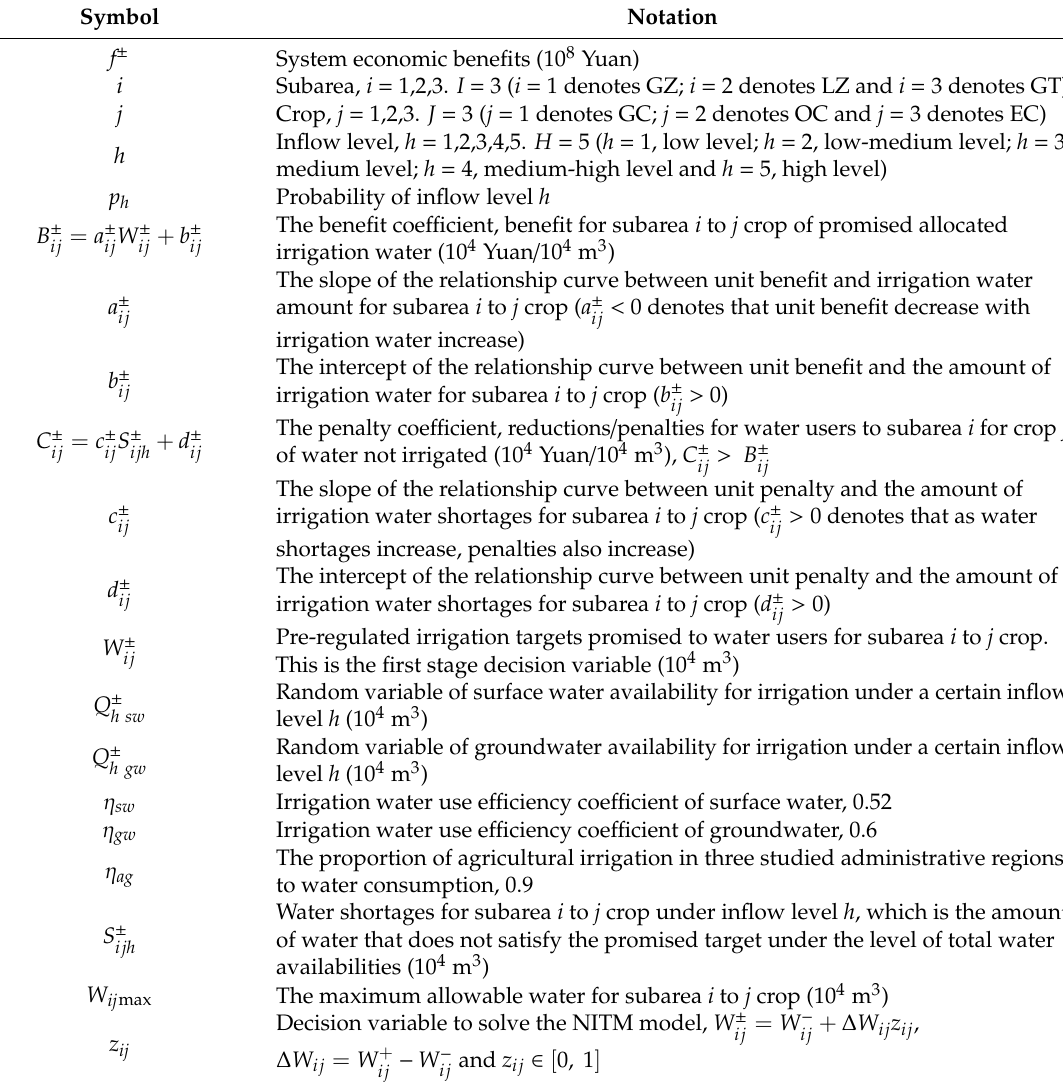
Table 1. Notation of the decision variables and input